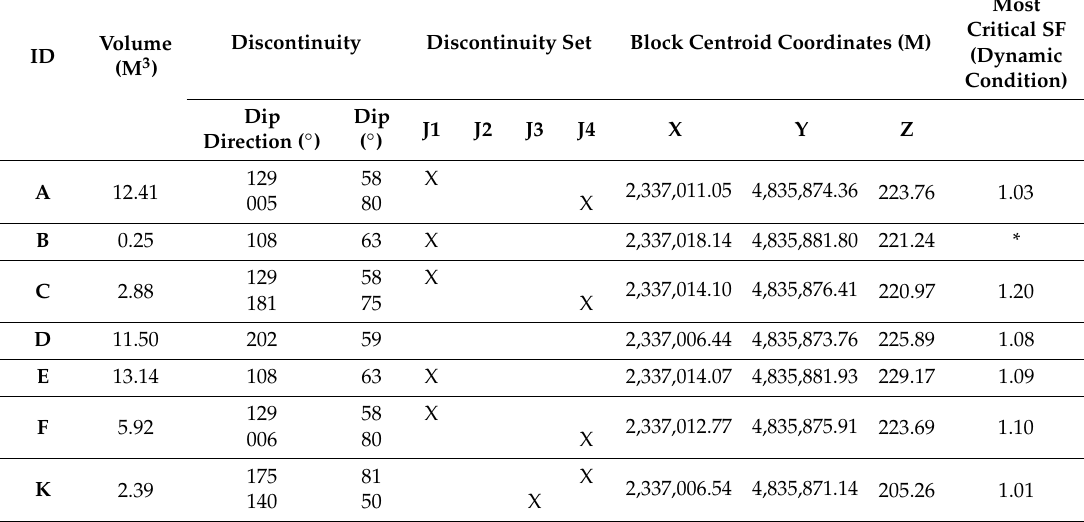
Table 4. Geometrical characteristics of unstable blocks identified on the slope and their most critical Safety Factors (SFs). * = SF not identified due to the presence of past remediation works (i.e., covering network and artificial